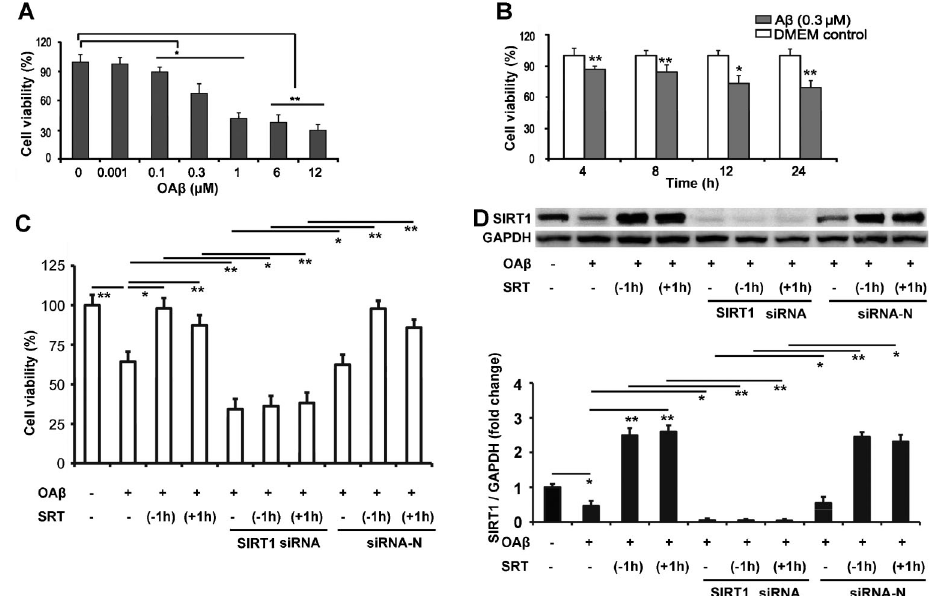
Figure 2. MTS assay of cell viability. A , MTS assay of cell viability after stimulation with different concentrations of OA b . Upon exposure to 0.001 m M OA b , no reduction of MTS activity was detected in cells, while a significant reduction was observed in response to 0.1- 12 m M OA b treatment after 24 h. B , MTS assay for cell viability after stimulation with 0.3 m M OA b for different times. RPE cells stimulated with 0.3 m M OA b demonstrated a time-dependent reduction of MTS activity dropping from 87.6% at 4 h to 68.4% at 24 h. C , MTS assay on normal or siRNA-transfected cells treated with OA b or SRT1720. SRT1720 attenuated OA b -induced decrease of cell viability, and knockdown of SIRT1 inhibited the protective effect of SIRT1 on cell viability. D , Western blot analysis of SIRT1 expression. The SIRT1 expression of OA b -stimulated cells was lower than that of control, and SRT1720 treatment significantly increased the SIRT1 expression in OA b -stimulated cells. Transfection with SIRT1 siRNA blocked SIRT1 expression in cells, but transfection with negative siRNA did not affect the inhibitory effect of SRT1720 on OA b -induced decrease of SIRT1 expression. Data are reported as means±SE from 4 measurements. Each panel shows a representative experiment repeated three times with similar results. SRT: cells treated with SRT1720; SIRT1 siRNA: cells transfected with SIRT1 siRNA; siRNA-N: cells transfected with negative control of siRNA. *P , 0.05, **P , 0.01 (unpaired t -test and